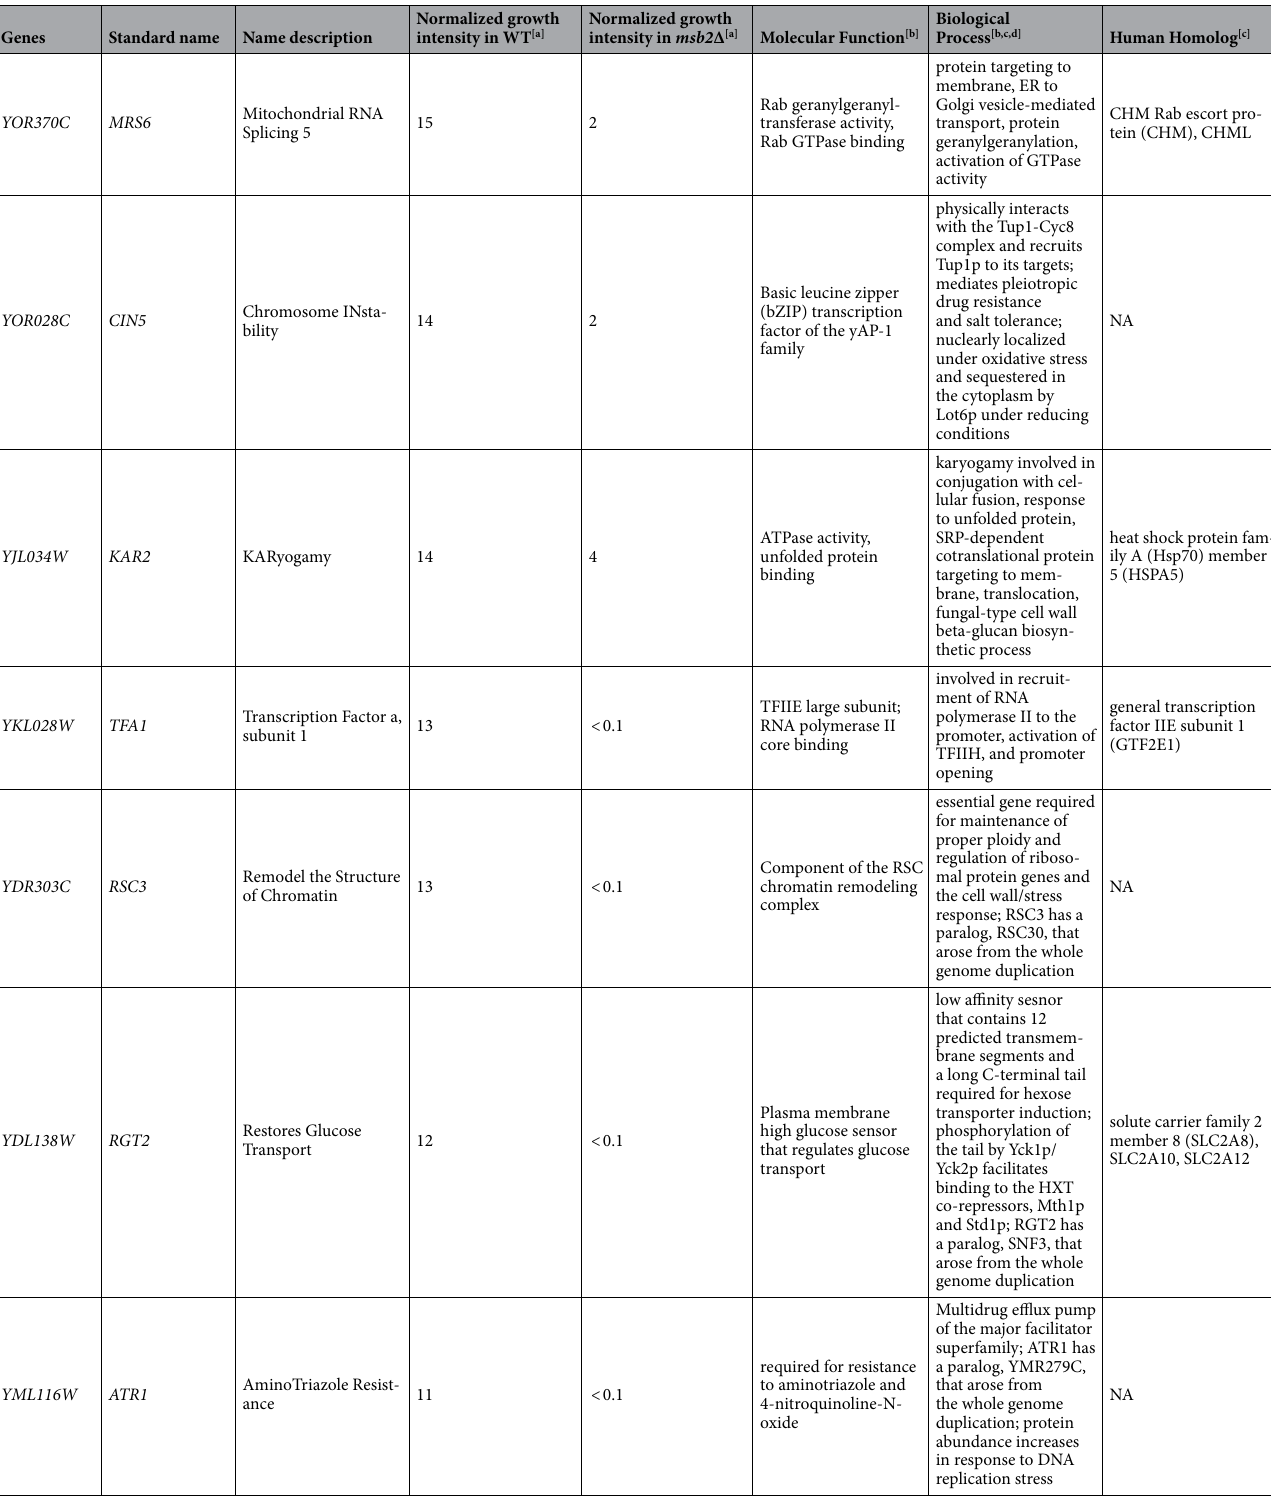
Table 1. Functional classification of MAPK pathway regulatory genes identified by gene overexpression alongside human homologs. [a] Spot intensity was measured by ImageJ analysis and was normalized to wild- type values (see Table S2 for the raw data). [b] Data comes from SGD (https ://www.yeast genom e.org/). [c] Data comes from Database Integration Tools (MARRVEL, Gene2Function, monarch INITIATIVE, ALLIANCE of GENOME RESOURCES, NCBI). [d] Not all biological processes are mentioned. [e] Growth intensity rates of the canididates validated in wild type is normalized to msb2 Δ mutant. [f] Not all homologs are listed